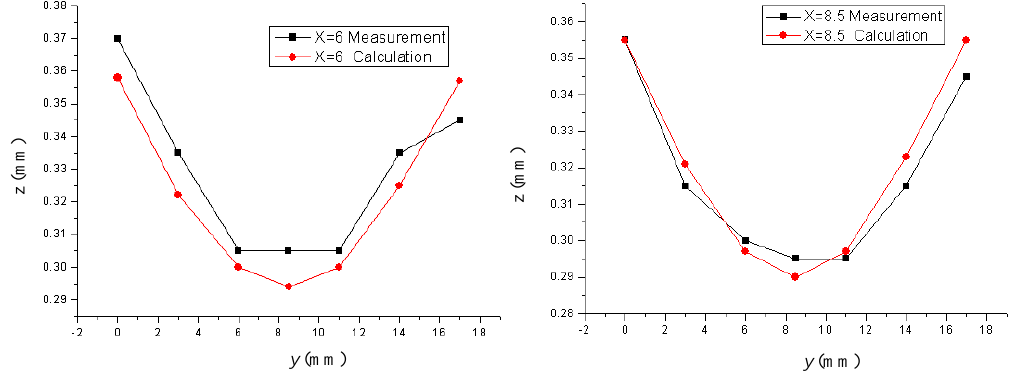
Figure 8. Comparison of the simulated result and the fabricated PWB.